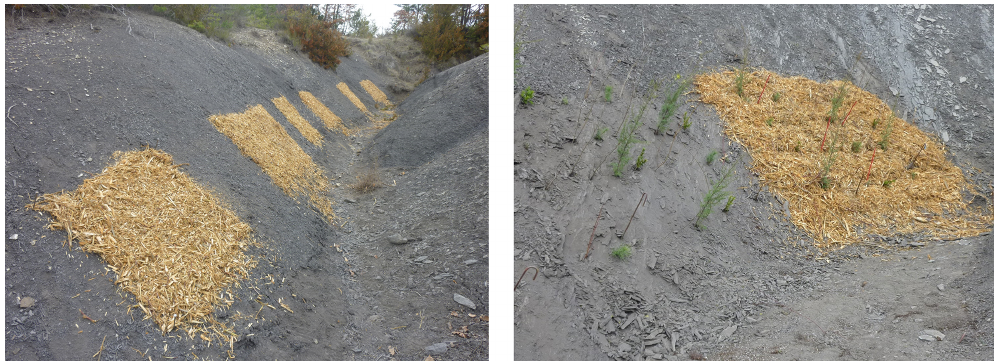
Figure 3. Pictures of the seed experiment setup (left) and the plant experiment setup